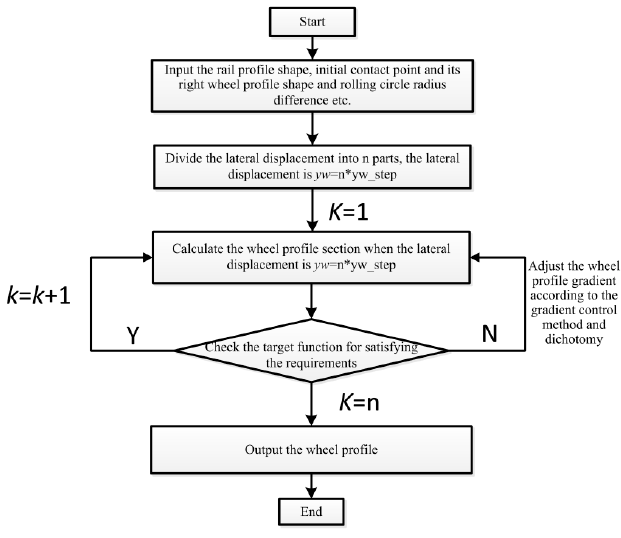
Figure 7. Flowchart.